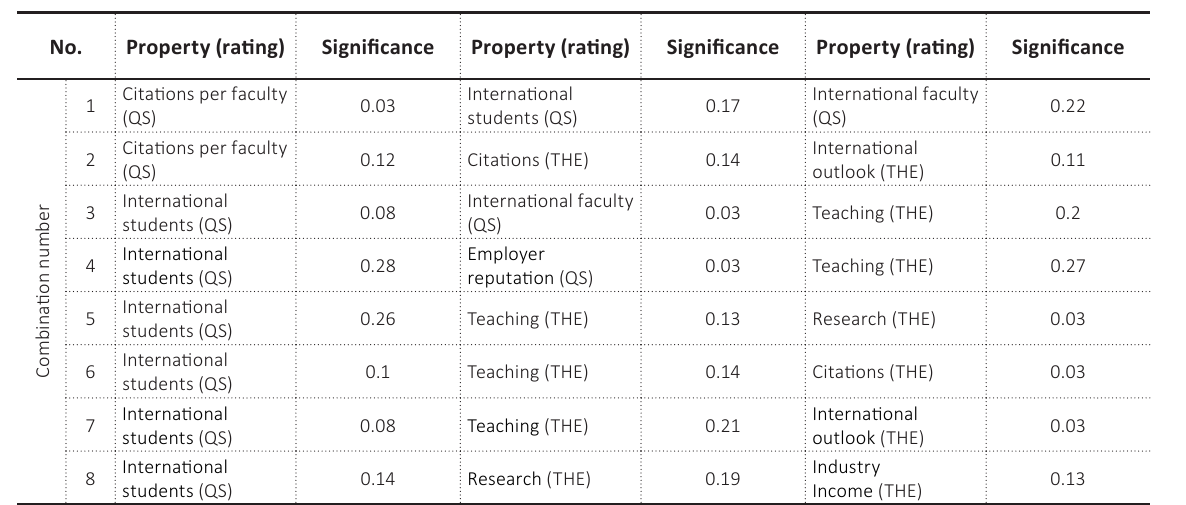
Table 5. Combinations of criteria with 100% discriminating ability, with each of them belonging to the rankings and assessment of individual significance,